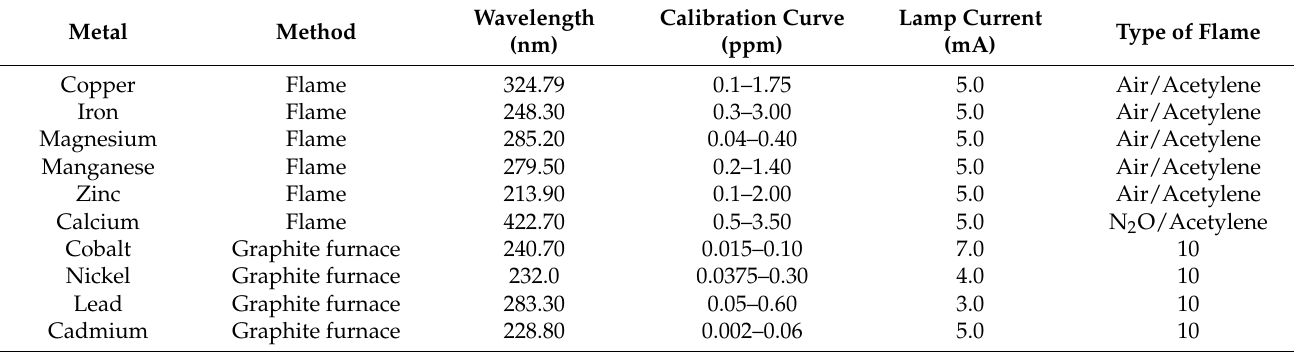
Table 1. Conditions of measure of metals in dry leaves of B. macrantha